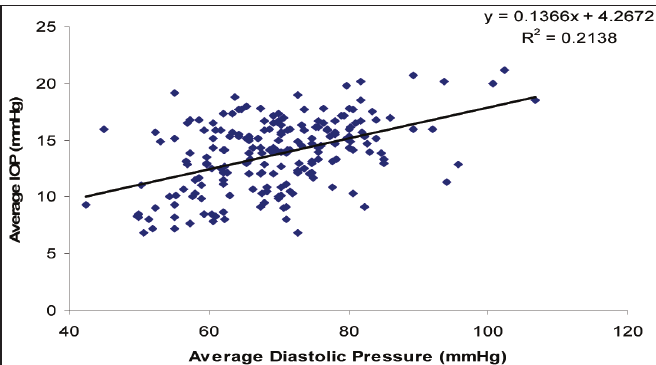
Figure 6: Relationship between average IOP and average di- astolic BP in males.